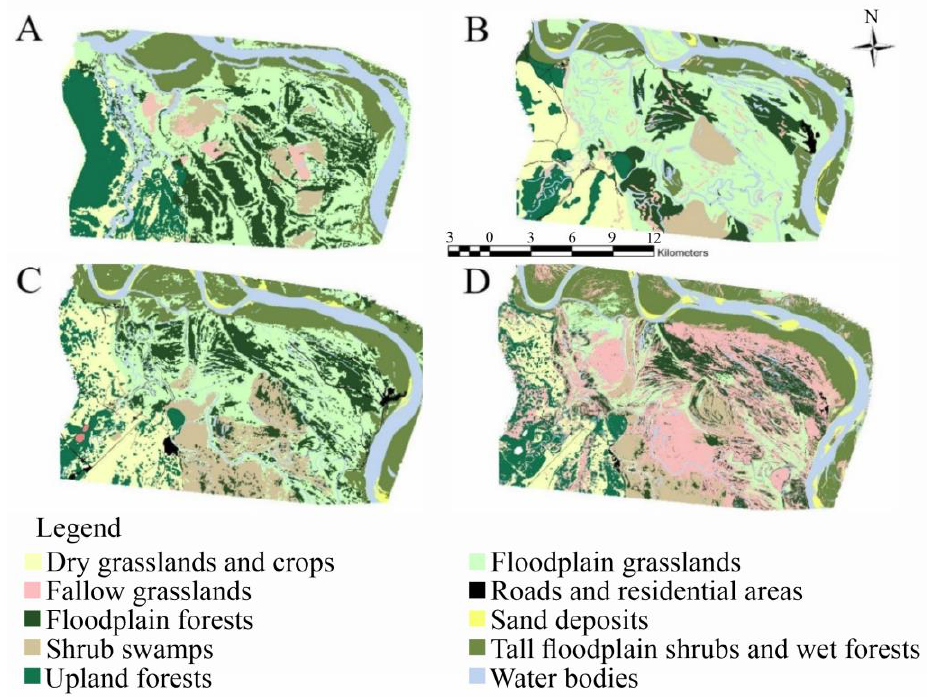
Figure 2. Land-cover maps at four time points: ( A ) topographic map from 1830s; ( B ) topographic map from 1950s; ( C ) CORONA, 08.1972; ( D ) Sentinel-2A, 08.2019. The average size of the delineated contours of the 1830 topographic map is 26.5 ha, and the minimum and maximum sizes are 0.5 and 5.5 ha, respectively. The open landscapes within the floodplain form the largest contours (up to 12.9 ha). Comparatively, the smaller areas are marshes, for which the average size of the contours is equal to 2403.8 ha. A large massif of riverside forests and large shrub thickets is located on the island on the northern part of the map. The largest massif of forests, with an area of 3070.4 ha, is located outside the floodplain on the interfluvial terrace on the western part of the map.